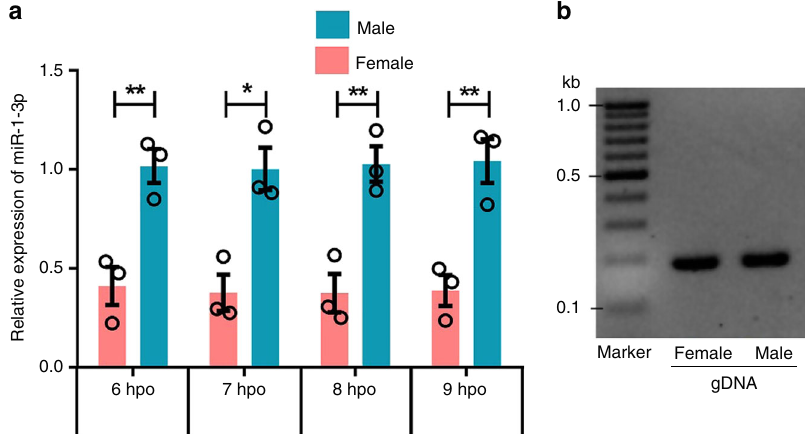
Fig. 4 The differential expression of miR-1-3p in female and male embryos. a Relative levels of miR-1-3p in single female and male embryos at 6, 7, 8, and 9 h post-oviposition (hpo). Female and male embryos were identi fi ed by the splicing patterns of Bdtra pre-mRNA. ( b ) PCR ampli fi cation of miR-1-3p from adult female and male genomic DNA. Error bars indicate the SEM of three independent biological replicates and asterisks (**) indicate the statistically signi fi cant differences ( P < 0.01) between the treatment group and control group based on Student ’ s t test.